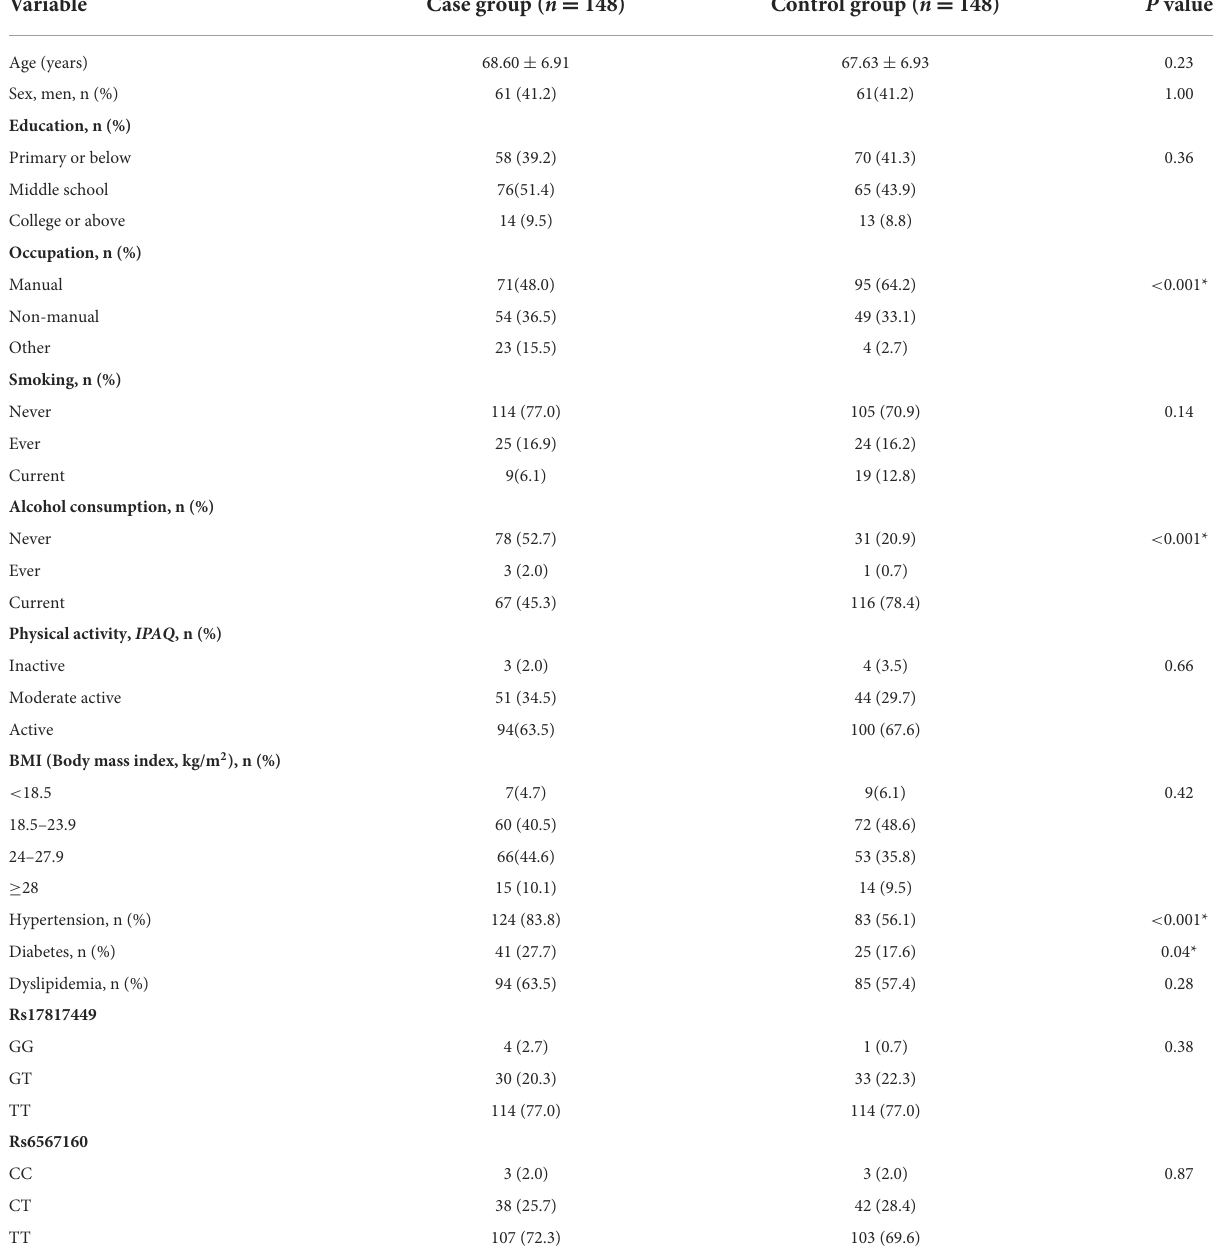
TABLE 1 Baseline characteristics of the study participants ( n =